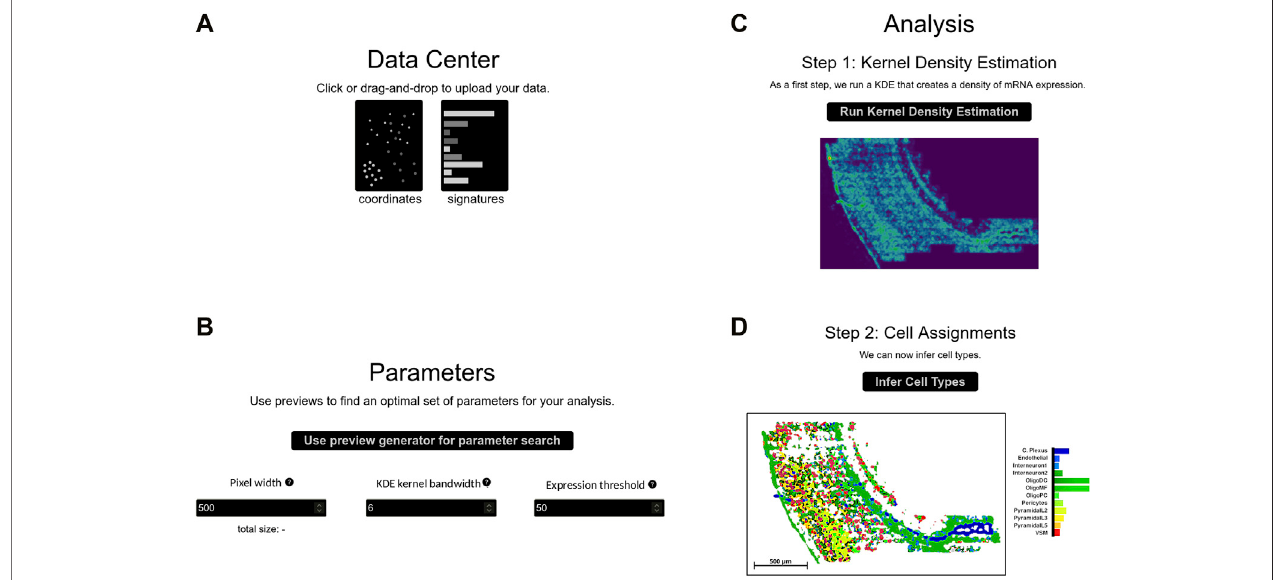
FIGURE 2 | The SSAM-lite interface. The panels display the sections of the SSAM-lite web page demonstrated on osmFISH data of the mouse SSp (Codeluppi etal.,2018): (A) thedatacenterforuploadingdata; (B) theparameterselectionandoptimizationsection; (C) the fi rstanalysissectionfordisplayingtheresultsoftheKDE analysis; and (D) the second analysis section for displaying the fi nal cell-type map